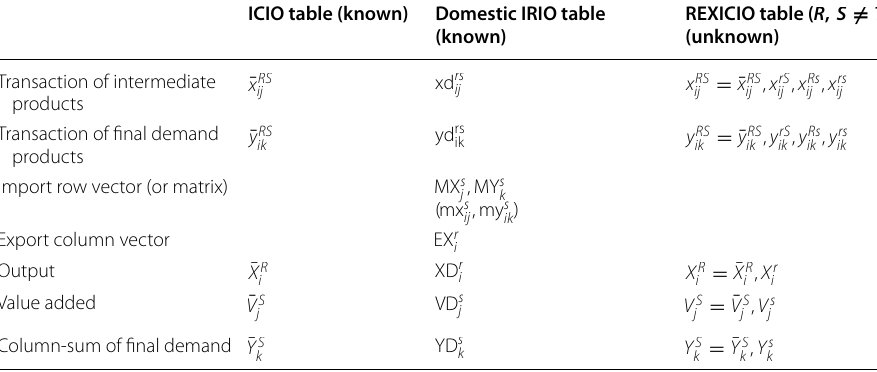
ex rS p and ey rS pk used in the paper are from customs data rather than IO tables. They represent target country’s domestic region r ’s exports to country S for good p by end‑use categories (ex: intermediate goods; ey: final goods)